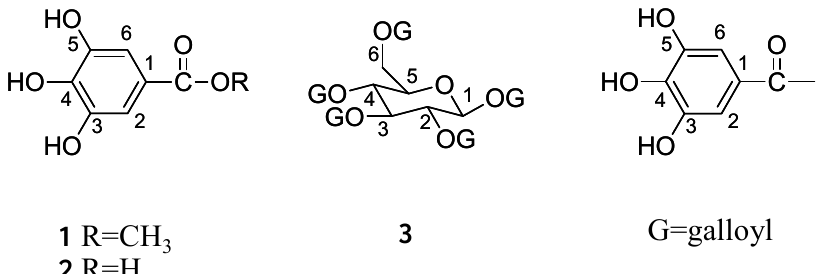
Figure 8. Chemical structures of three major constituents of Thai mango seed kernel extract: MG ( 1 ), GA ( 2 ) and PGG ( 3